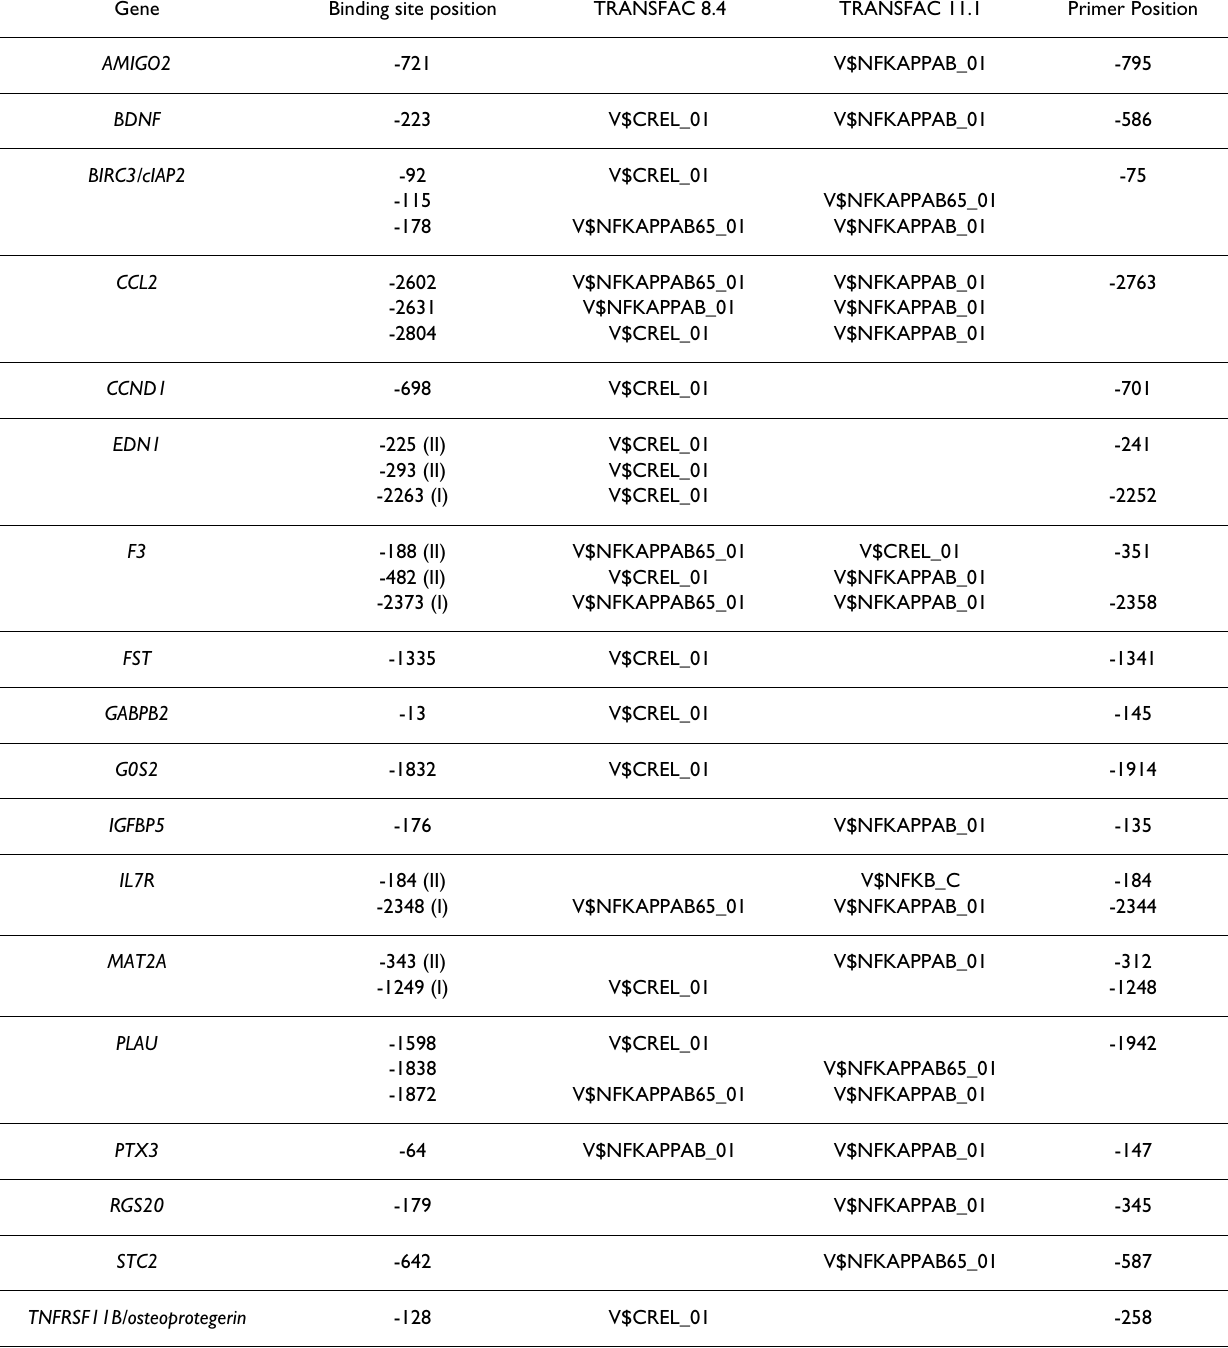
Table 6: NF  B binding sites confirmed by chromatin immunoprecipitation.